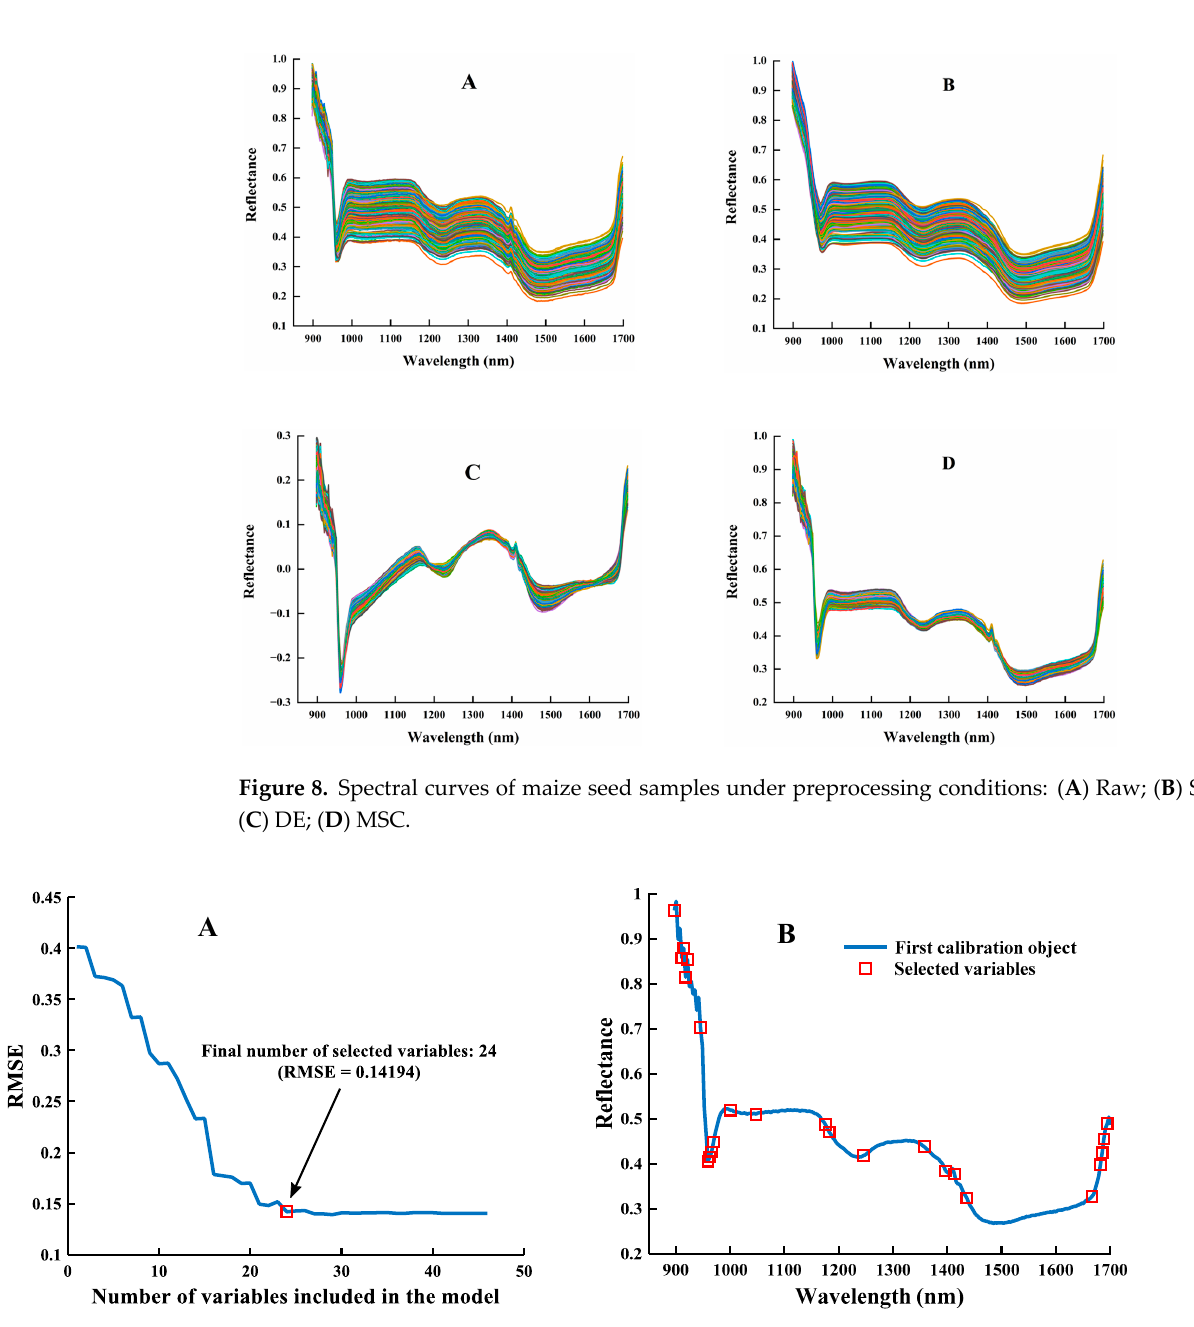
Figure 9. SPA selected feature wavelengths: ( A ) the value of RMSE varies with the number of variables; ( B ) the selected wavelength variables.